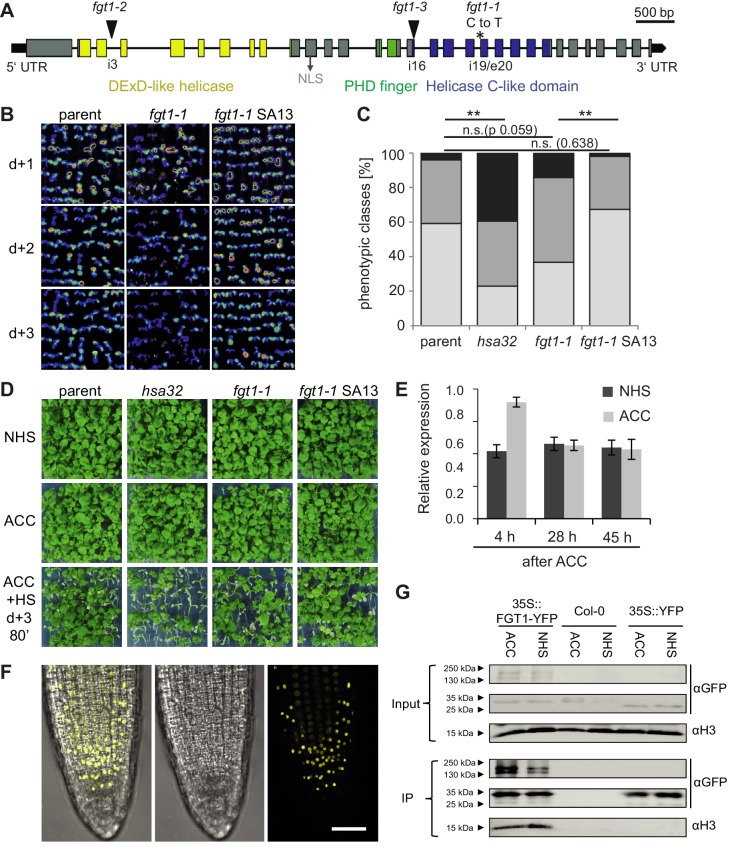
FGT1 encodes the A. thaliana orthologue of Drosophila Sno and binds histones.(A) Gene model of FGT1 (At1g79350) with domains and location of mutations; exons (grey and colored bars); black line, intron. fgt1-1 has a C to T mutation at the splice acceptor site of intron 19/exon 20. (B–D) Complementation of fgt1-1 by a genomic FGT1 fragment (SA13). (B) pHSA32::HSA32-LUC-derived bioluminescence of indicated genotypes assayed 1, 2, or 3 d after ACC. (C,D) Seedlings of the indicated genotypes were acclimatized 5 d after germination and received a tester HS 3 d later. (C) Quantification; n = 48–49, Fisher’s exact test, **p<0.01. (D) Representative picture taken after 14 d recovery. (E) FGT1 transcript levels increase transiently after ACC. Relative FGT1 transcript levels were determined by qRT-PCR and normalized to At4g26410. Errors are SE of two biological replicates. (F) FGT1 is localized to the nucleus in 3 d-old seedling roots. 35S::FGT1-YFP transgenic seedlings were imaged for YFP fluorescence. Left, overlay; middle, bright field; right, YFP fluorescence. Scale bar, 40 µm. (G) FGT1 binds histone H3 in vivo. Nuclear protein extracts of transgenic 35S::FGT1-YFP, 35S::YFP and non-transgenic Col-0 seedlings harvested 28 h after the indicated treatments were immuno-precipitated with anti-GFP antibody. Co-purification of histone H3 was assessed by immunoblotting.